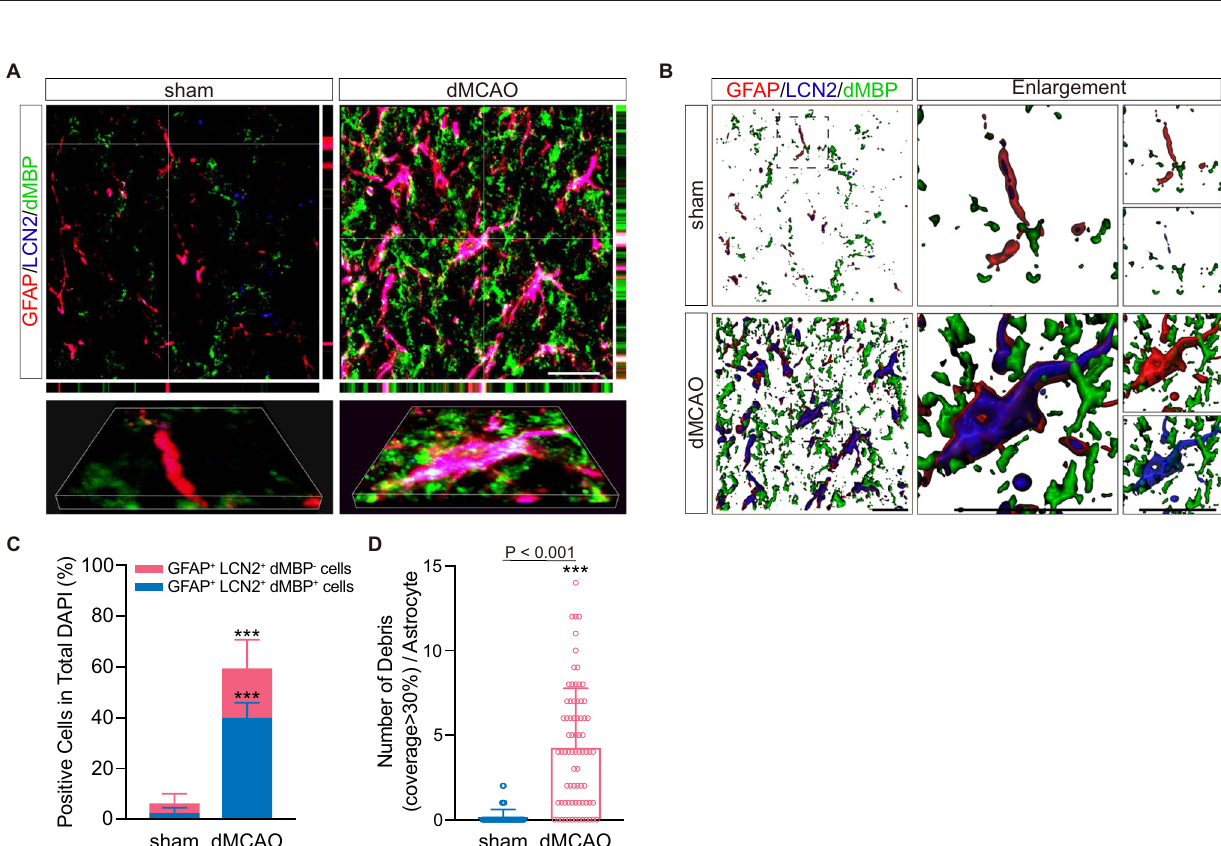
Fig. 3 LCN2-positive astrocytes can engulf myelin debris after dMCAO. A Representative confocal images of myelin debris (dMBP + , green) surrounded by LCN2 + (blue) astrocytes (GFAP + , red) in CC after ischemia. Scale bar, 20 μ m. B Images were reconstructed from confocal images using Imaris software. High-magni fi cation images were shown in the right panel. Scale bar, 20 μ m. C Quanti fi cation showing the changes of LCN2-positive astrocytes (GFAP + ) containing myelin debris (dMBP + ) 7 days after dMCAO according to immunostaining ( n = 5 mice; mean ± S.D.; compared to sham, *** P = 0.00003 for GFAP + LCN2 + astrocytes, *** P = 0.0003 for GFAP + LCN2 + dMBP + astrocytes; paired t -test). D Quanti fi cation of the pieces of myelin debris contacted with (coverage >30%) or internalized by a single astrocyte according to 3D reconstruction images ( n = 75 cells from fi ve animals in each group; mean ± S.D.; *** P < 0.001 vs. sham; paired t -test). Source data are provided as a Source Data fi latency; F = 0.447, P = 0.942 for path length), suggesting that the with adjusted P of 0.0083, P = 0.0065). Cognitive function was grouping effect was not correlated with time progression. Post assessed by Morris water maze. In the initial phase of the fi rst the platform and swam longer distances than sham mice spatial learning ability 20 . Two-way repeated-measures ANOVA revealed an apparent time effect ( F = 61.78, P < 0.001 for escape (Fig. 6J – L). Lcn2 − / − dMCAO mice exhibited notably alleviated latency; F = 28.74, P < 0.001 for path length) and grouping effect spatial learning de fi cits on the 4th and 5th days of the training, as ( F = 23.04, P < 0.001 for escape latency; F = 13.18, P < 0.001 for indicated by a shorter swimming time to fi nd the platform path length). However, there was no evident interaction between (Fig. 6K; compared to WT dMCAO group, P = 0.043 and time progression and grouping ( F = 1.162, P = 0.314 for escape P = 0.009 respectively). However, no statistical difference in path